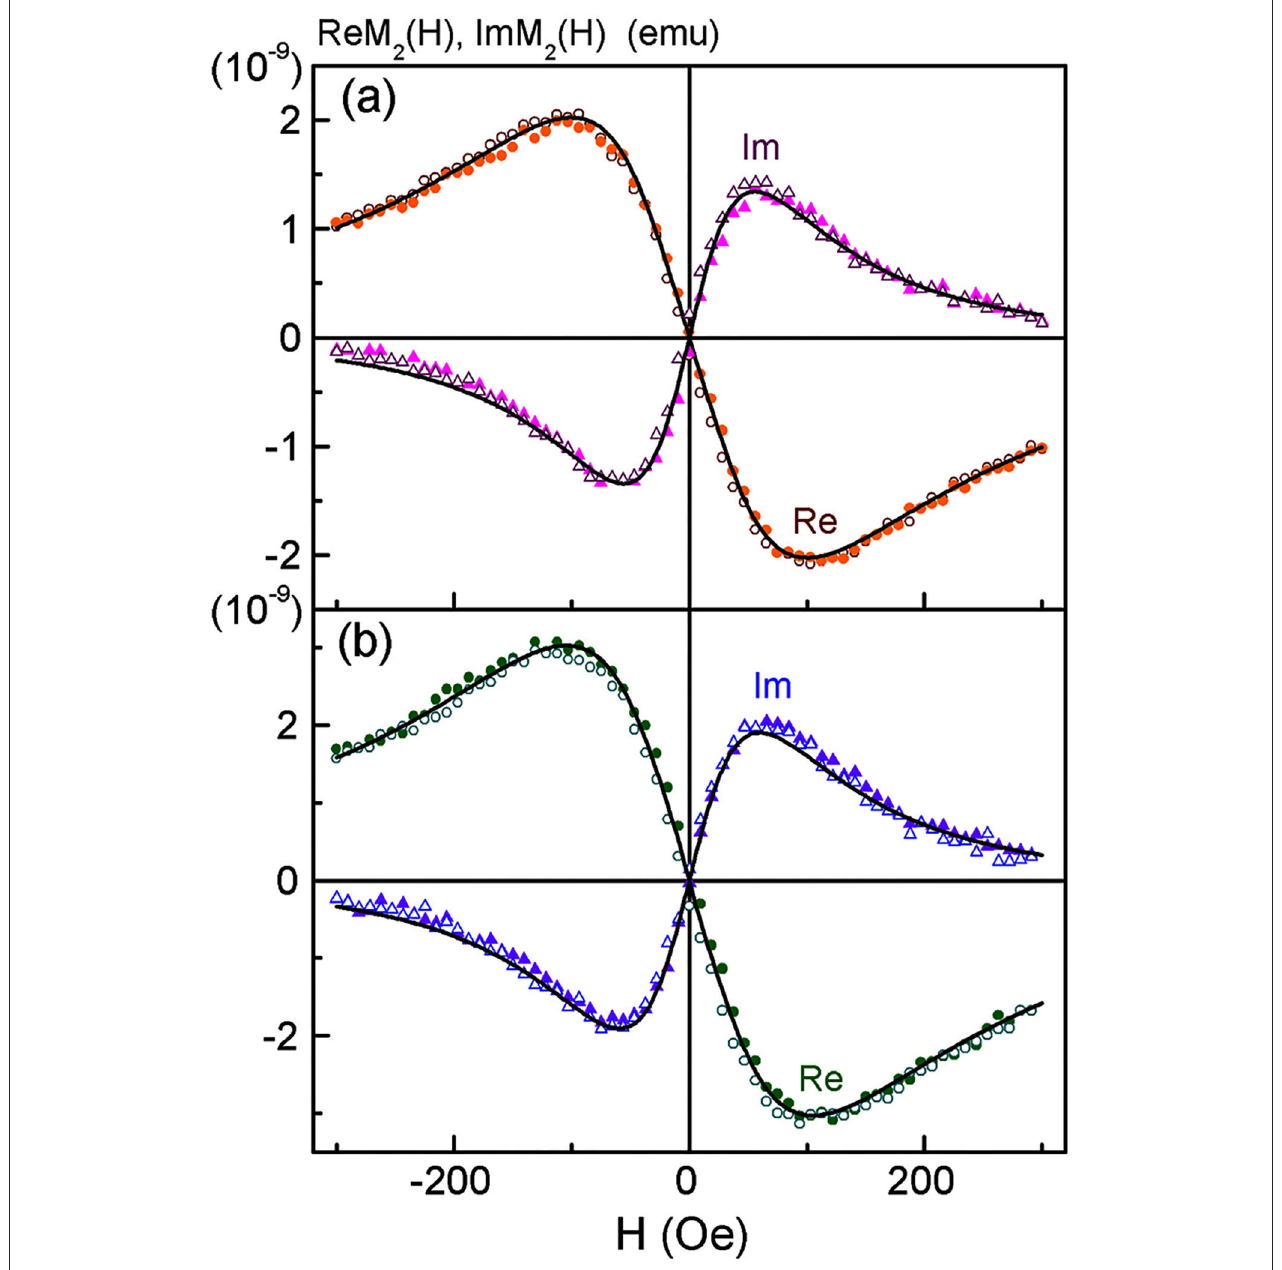
FIGURE 5 | Real and imaginary parts of non-linear magnetic response vs. dc magnetic field, direct (filled symbols) and reverse (open symbols) scans with F sc for SPION-labeled MSCs suspensions in PBS (a) and formalin (b) after co-incubation of MSCs at the concentration of iron 150 µ g/ml for 24h. Every 32nd point is shown. Black curves in (a) and (b) are best fit. Obtained parameters for (a) are presented in Table 1